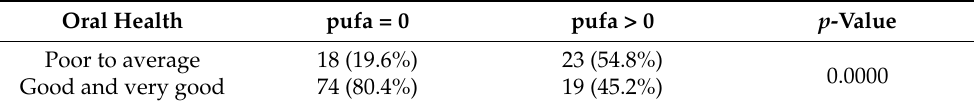
Table 4. Oral health in examined children as rated by their parents according to pufa. Oral Health pufa = 0 pufa > 0 Poor to average